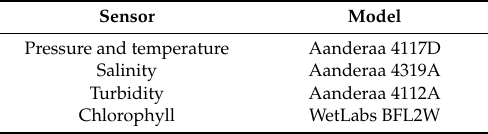
Table 1. Oceanographic variables and sensors used at the LoVe monitoring site for statistic comparison with P. arborea polyp extrusion / activity rhythms.